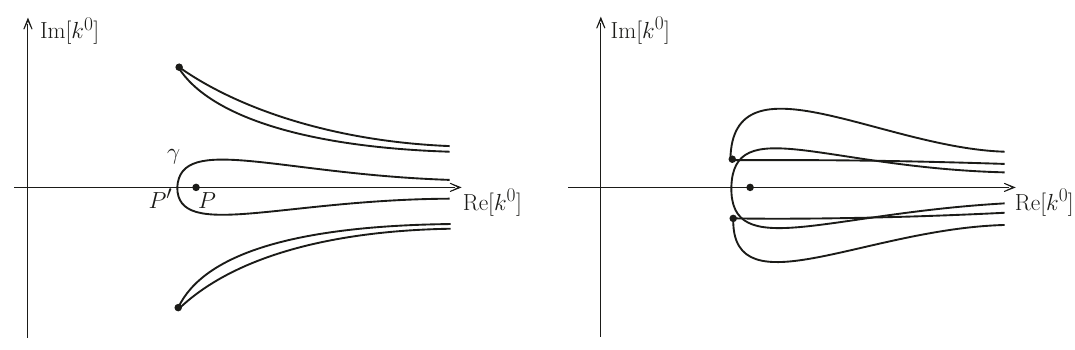
Figure 10 . Solutions of the Lee-Wick pinching conditions at p